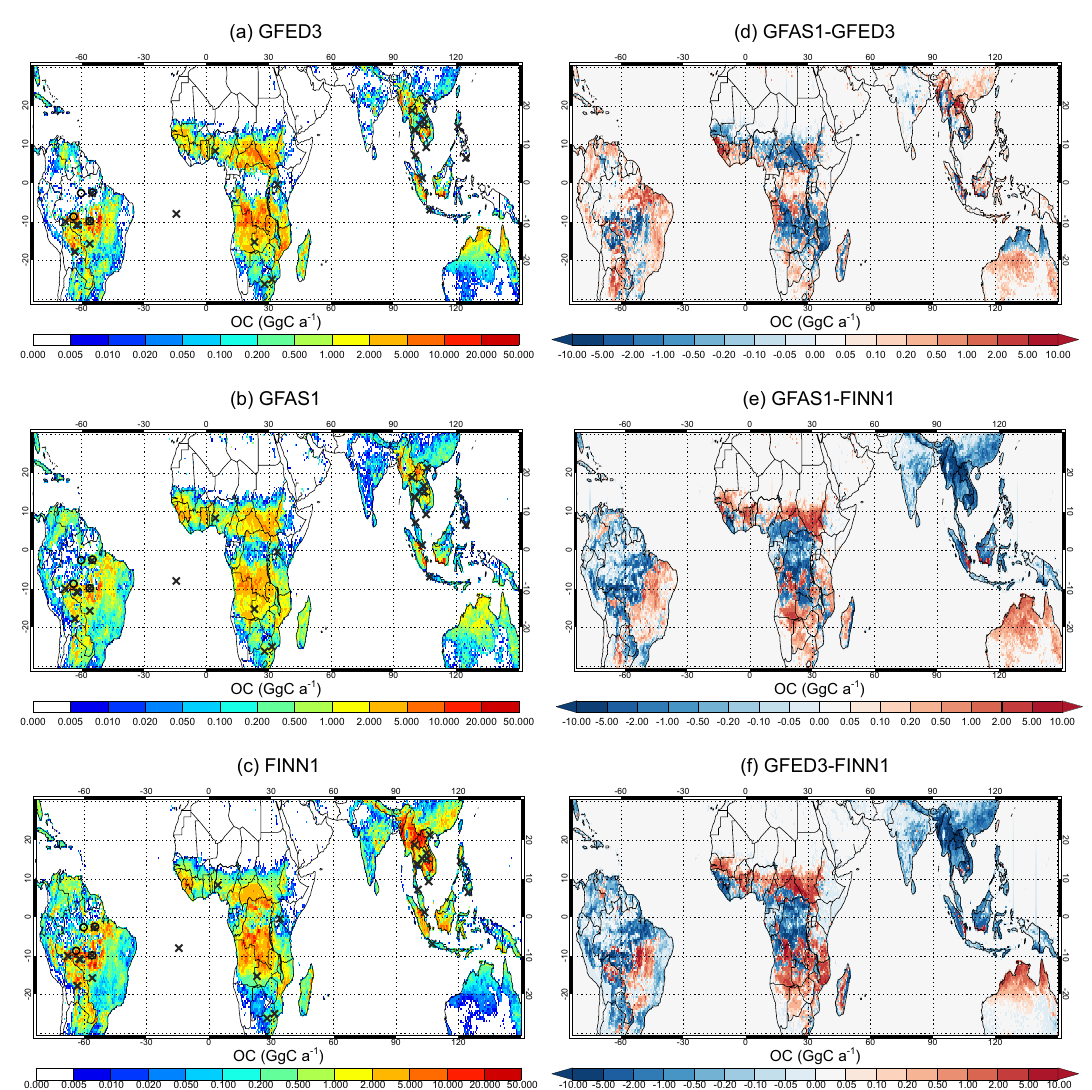
Figure 1. (a–c) Total annual emissions of organic carbon (OC) in Gg(C)a − 1 averaged over the period of January 2003 to December 2011 from (a) GFED3, (b) GFAS1 and (c) FINN1. Black circles mark the locations of the four aerosol measurement stations and black crosses mark the locations of the 27 AERONET stations (see Table S1). (d–f) Absolute difference in 2003–2011 mean annual OC emissions between GFAS1, GFED3 and FINN1, (d) GFAS1 minus GFED3 (e) , GFAS1 minus FINN1, and (f) GFED3 minus FINN1. The FINN1 OC emissions (with a 1km × 1km horizontal resolution) were aggregated onto a grid of 0.5 ◦ × 0.5 ◦ resolution to compare with GFED3 and